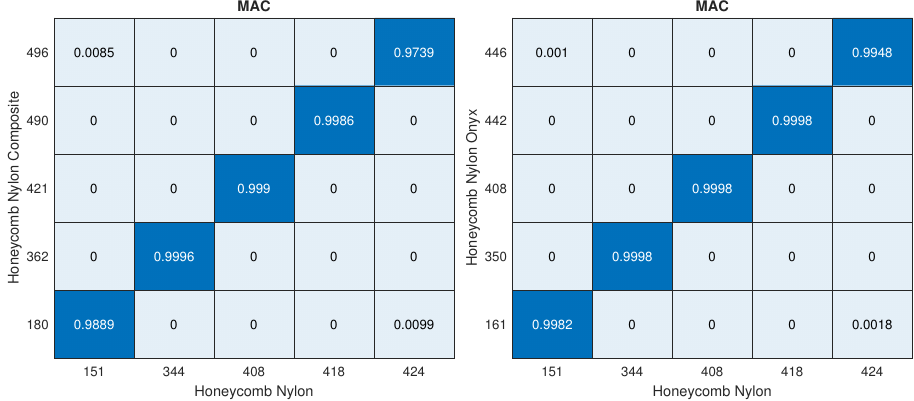
Figure 9. MAC results of honeycomb lattice structure: